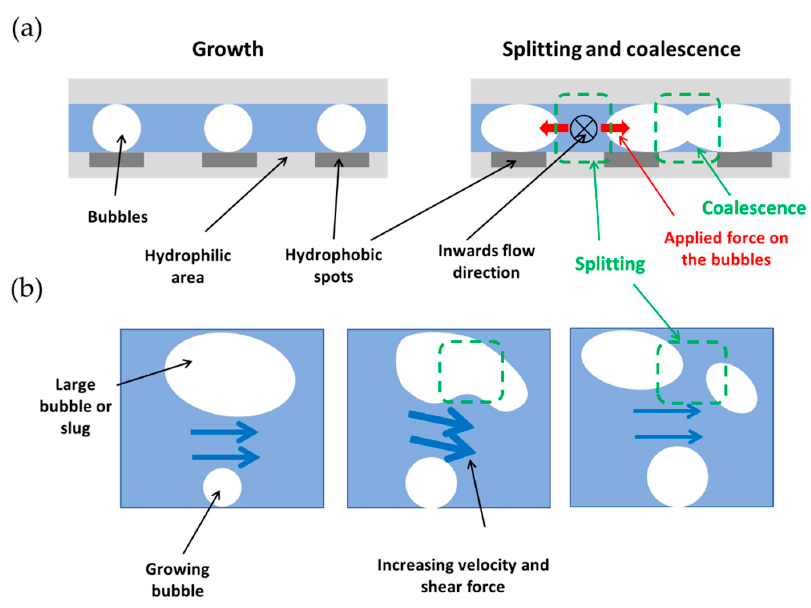
Figure 9. Schematic of the ( a ) bubble breakup in the stream ( b ) bubble coalescence and splitting in the biphilic surfaces.